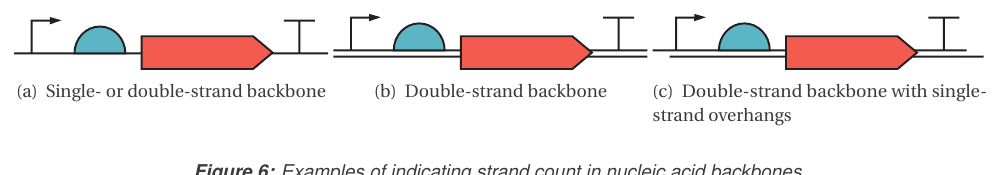
Figure 6: Examples of indicating strand count in nucleic acid